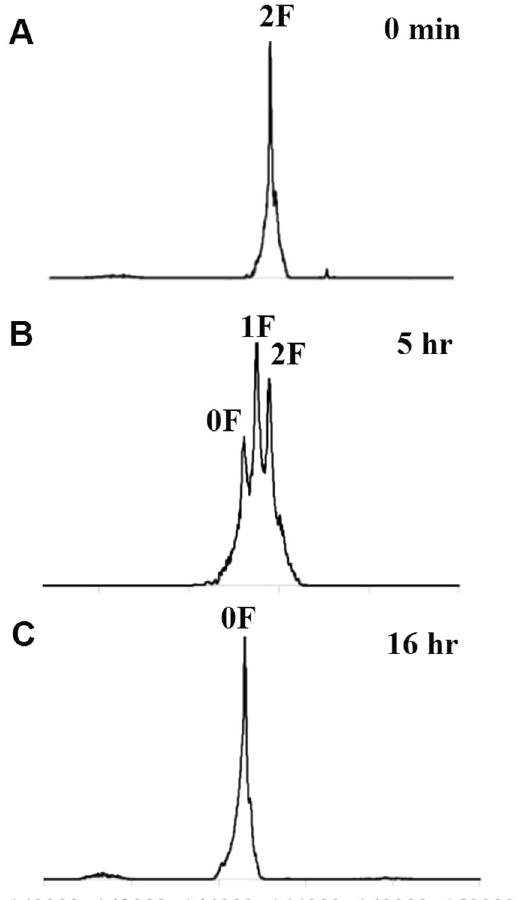
Figure 7. MS profiles of IgG defucosylation by a fucosidase under real-time monitoring. ( A ) IgG- Fuc α 1,6GlcNAc before treatment of fucosidase; ( B ) after treatment of fucosidase for 5 hours; ( C ) after treatment of fucosidase for 16